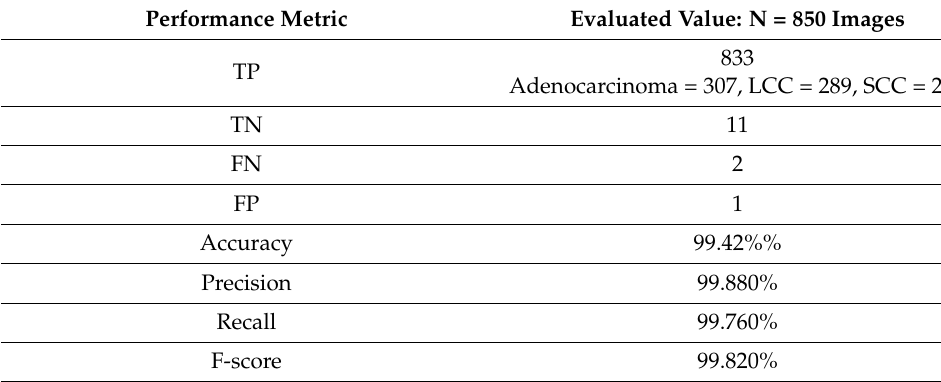
Table 6. The evaluated performance analysis of combined VGG-19 and LSTMs.